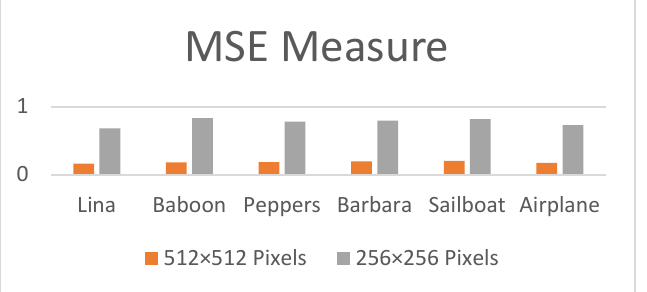
Figure 5. MSE measure for embedding 2000 bytes in colour images of sizes 512 × 512 and 256 × 256.